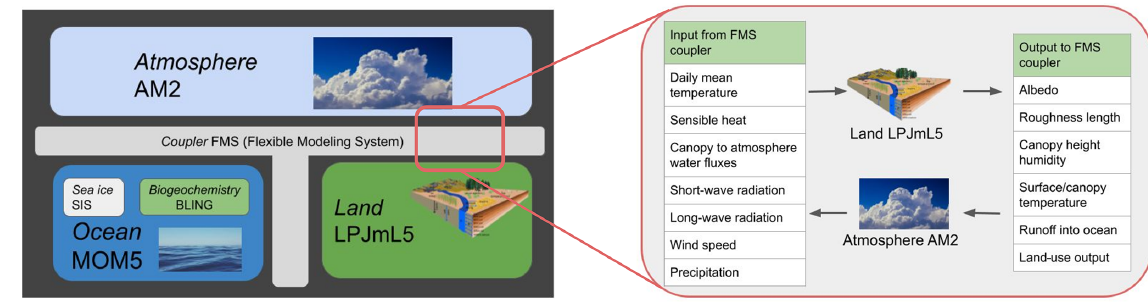
Figure 1. Schematic overview of CM2Mc-LPJmL and the most important variables exchanged between LPJmL5, FMS and AM2.